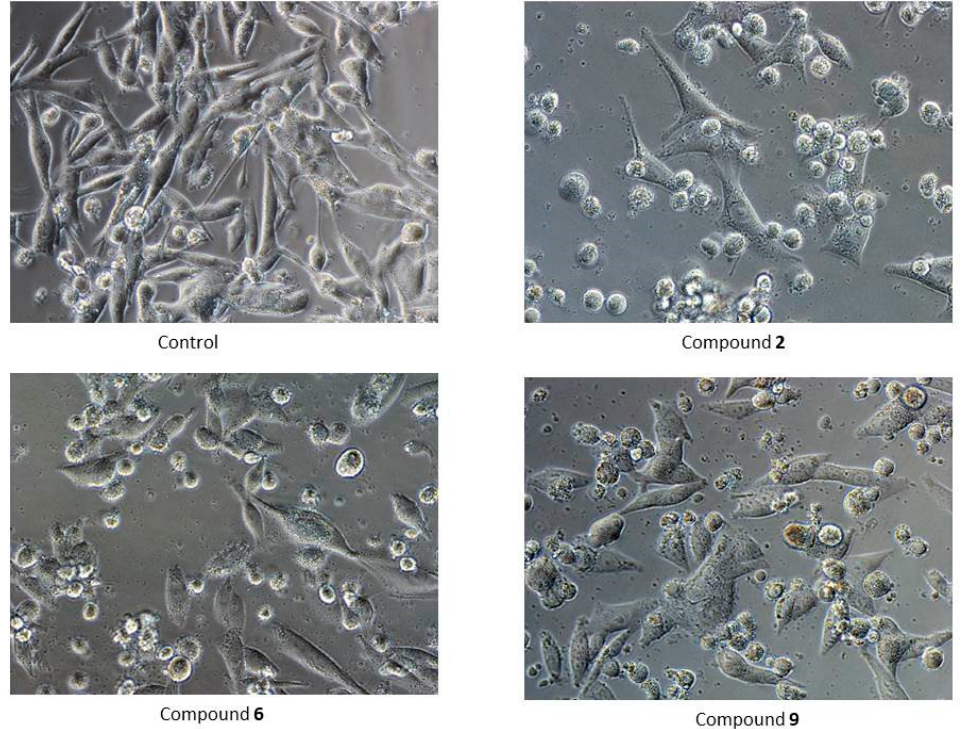
Figure 4. Morphology of G-361 cells after 24 h treatment with compounds PK2, PK6 and PK9 in concentrations corresponding to appropriate IC 50 values or DMSO as a vehicle in control culture (magnification ×400).